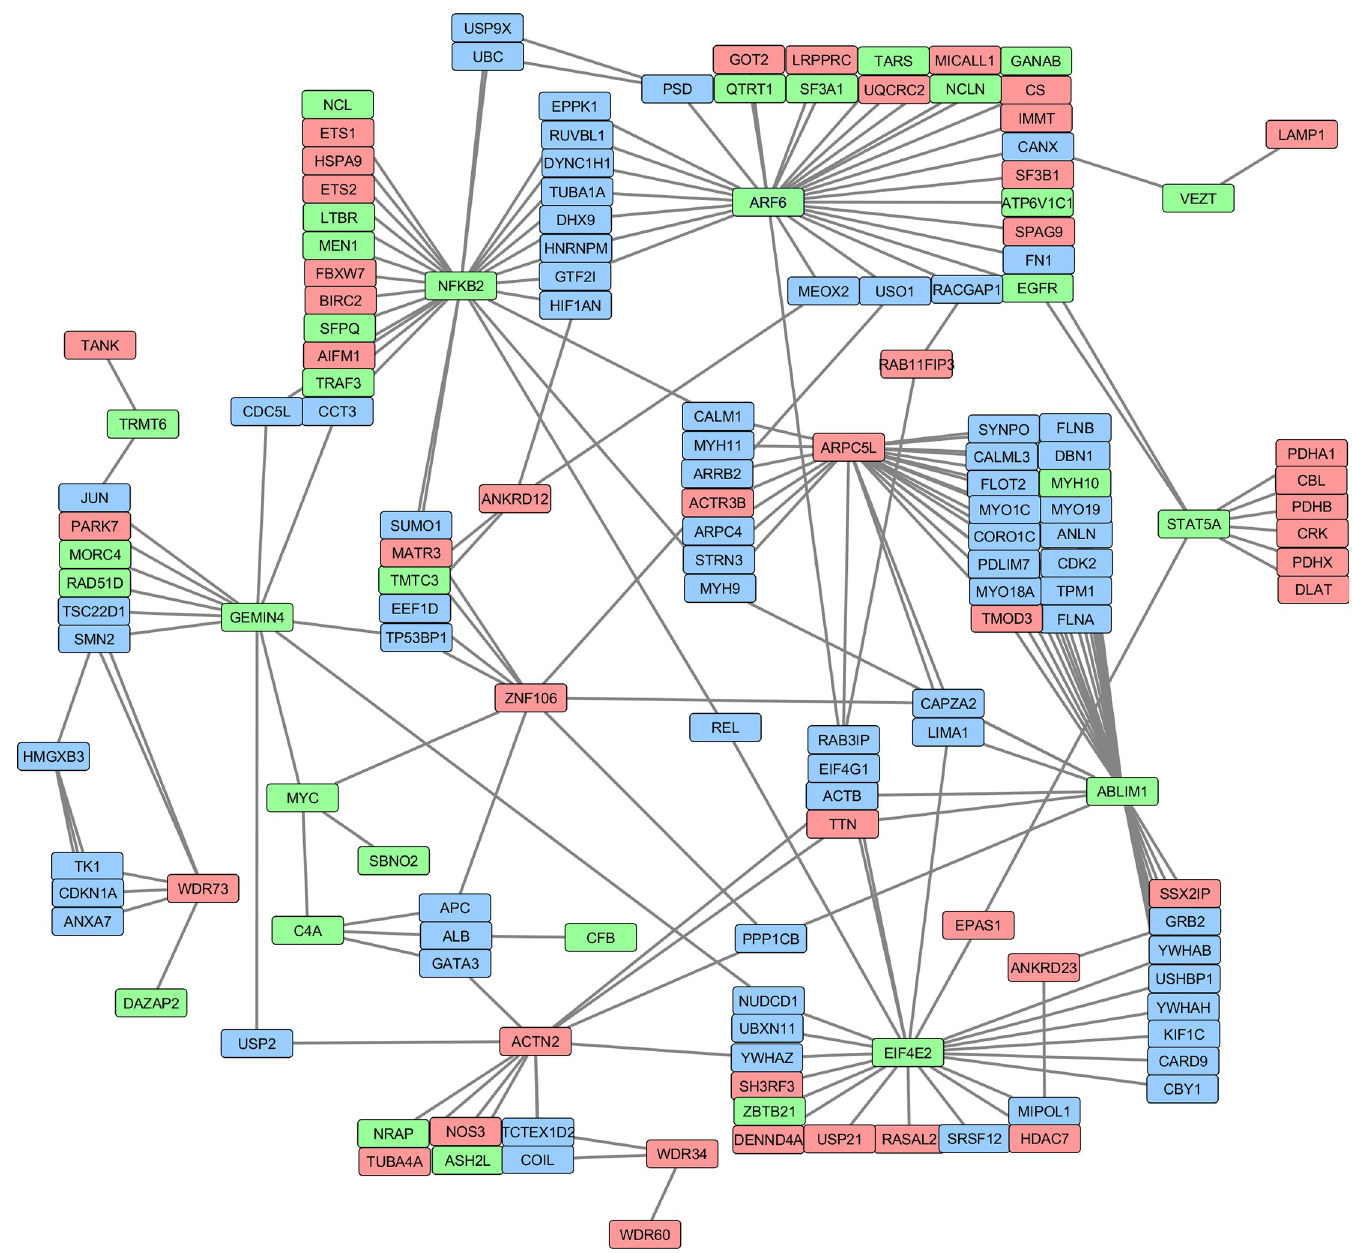
Fig 6. Protein-protein interaction network showing upregulated (green) and downregulated (red) genes in tender meat from longissimus dorsi muscle sampled in a multibreed Angus-Brahman population. Blue boxes show genes that were not identified in the expression or DE analysis but are part of the network.